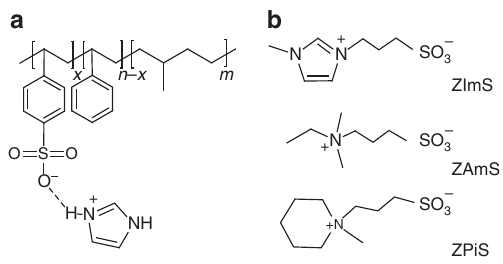
Figure 1 | Molecular structures. ( a ) Molecular structure of imidazole- doped PSS- b -PMB block copolymer and ( b ) molecular structures of ZImS, ZAmS and